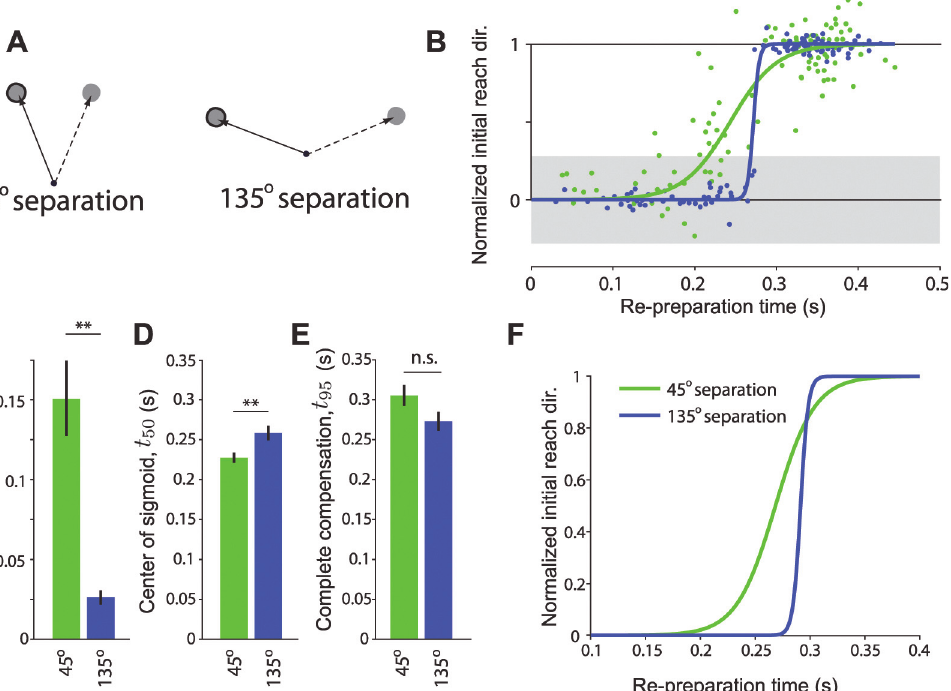
Fig 4. Experiment 2 results. A) Only two target locations were possible within each block, either separated by 45°, or 135°. The target was jumped on 30% of trials. Solid arrow/bold target indicates movement required before target jump. Dashed arrows indicate potential movements required after a target